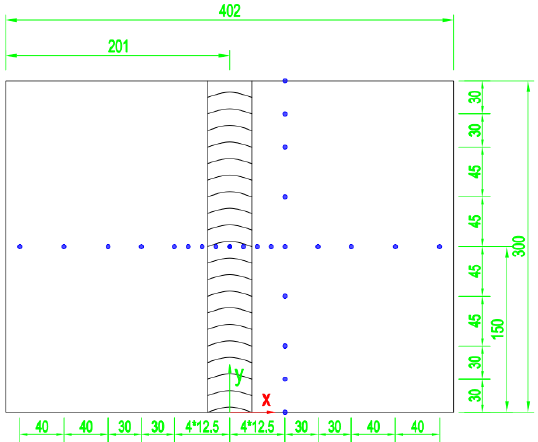
Figure 9. Measuring points on surface B (unit mm).